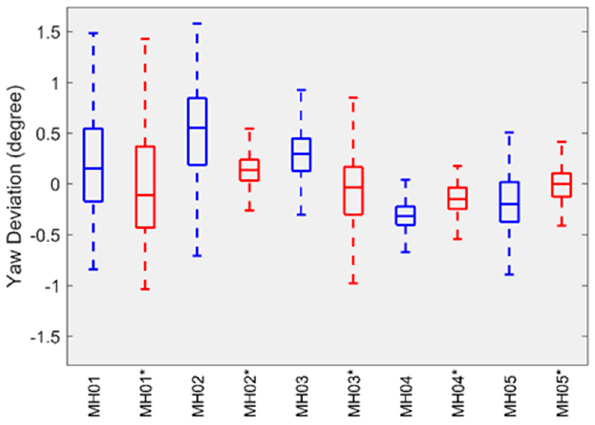
Figure 4. The yaw error of our implementation on Machine Hall datasets.